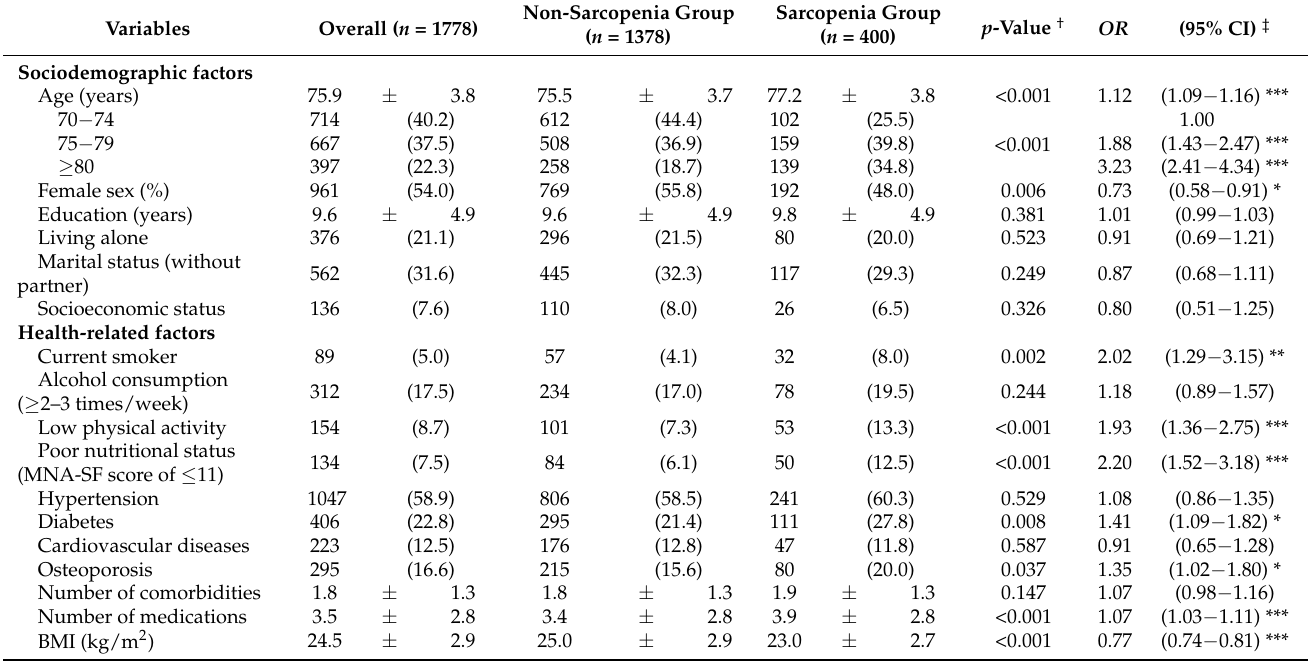
Table 1. Characteristics of participants in the non-sarcopenia and sarcopenia